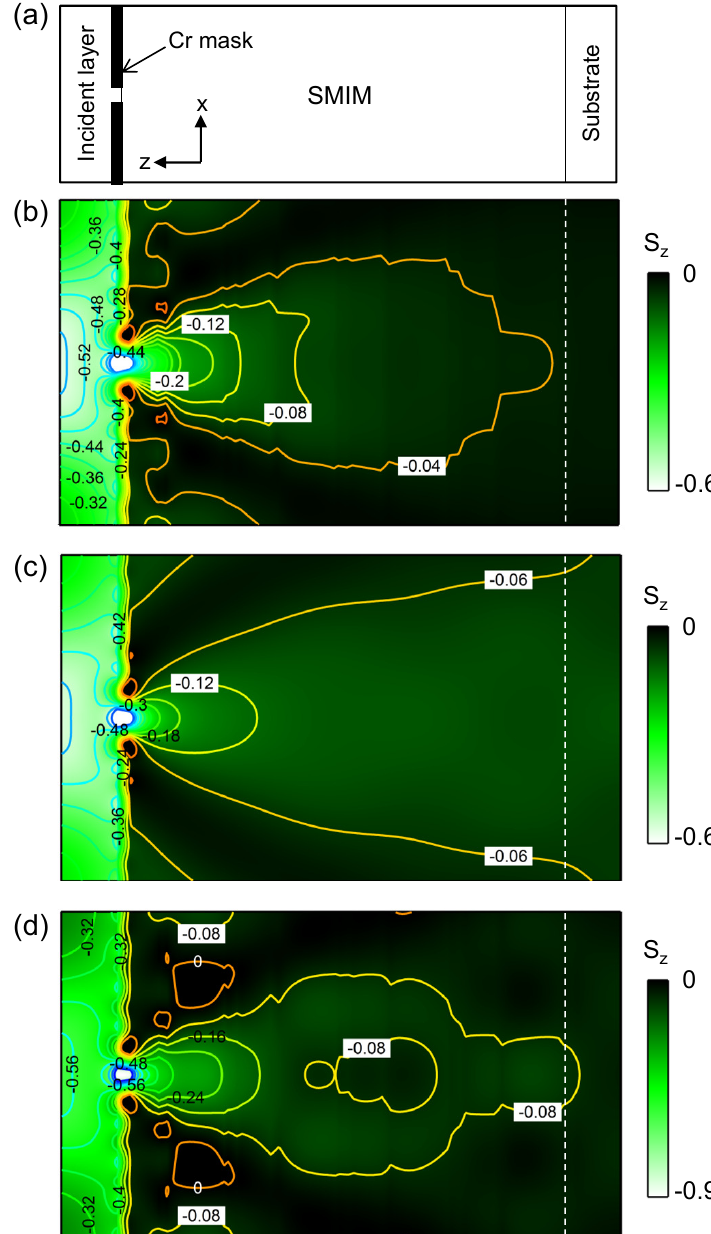
Figure 6. ( a ) Configuration of a SMIM with narrow Cr mask with a 25-nm slit. ( b ) Propagation of the deeply subwavelength object image via the hyper mode at 510.0 nm in the SMIM of six-layer unit cell. The S component is shown with pseudo-color and contours. z ( c ) Propagation in the SiO substrate after going through the Cr slit. ( d ) Propagation of the 2 = 2 . 1316 − 0 . 05 i . subwavelength object image in a SMIM, including the gain insulator of ε g In (b)–(d), the xz axes are set similarly to (a); the Cr slit located at the half height in each panel is represented at the same dimensions to that in (a); and the positions of the SMIM / substrate interface are indicated by dashed lines in (b) and